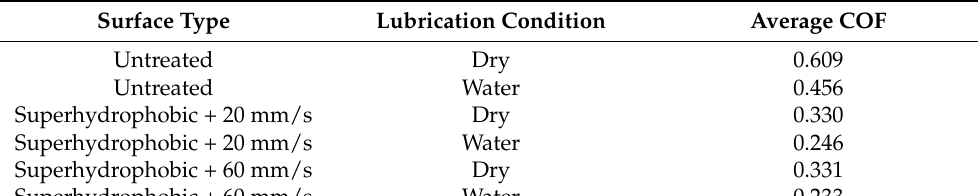
Table 3. Average COF for different types of BMG surfaces under dry sliding and water lubrication conditions.